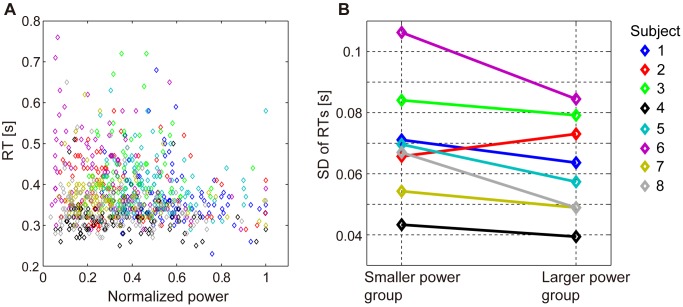
Relation between powers of components reflecting brain activities of unlocked waveforms and variability of RTs in Go condition.
A: Scatter plot of normalized power and RTs. Each dot corresponds to one trial of one subject. B: SDs of RTs in smaller and larger power groups. In both figures, each color corresponds to one subject.